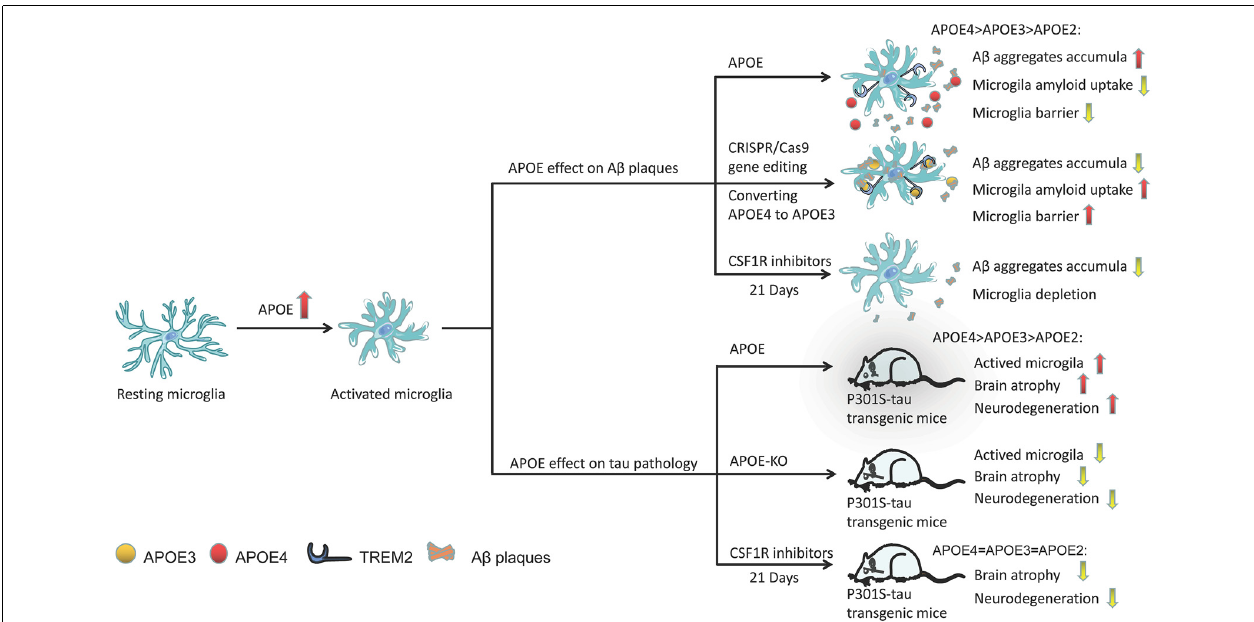
FIGURE 3 | Activation of the role of APOE in microglia under different pathological conditions. APOE in plaques may increase A β clearance by binding to TREM2 and activating microglia, promoting microglial migration and phagocytosis, and its efficacy varies with APOE subtype (APOE2 > APOE3 > APOE4). Through CRISPR/Cas9 gene editing, converting APOE4 to APOE3 can enhance the ability of microglia to absorb extracellular A β . Similarly, the presence of APOE (especially APOE4) significantly aggravates the neurodegeneration of p301 mice. However, APOE-KO has a powerful neuroprotective effect in tauopathy transgenic mice, reducing the activation of microglia and improving brain atrophy in mice. CSF1R inhibitor-mediated depletion of microglia in P301S-tau transgenic mice can also completely prevent the progression of tau